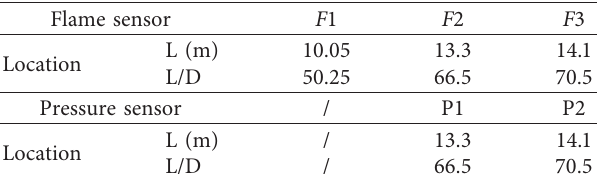
Table 1: Arrangement of flame and pressure sensors. Flame